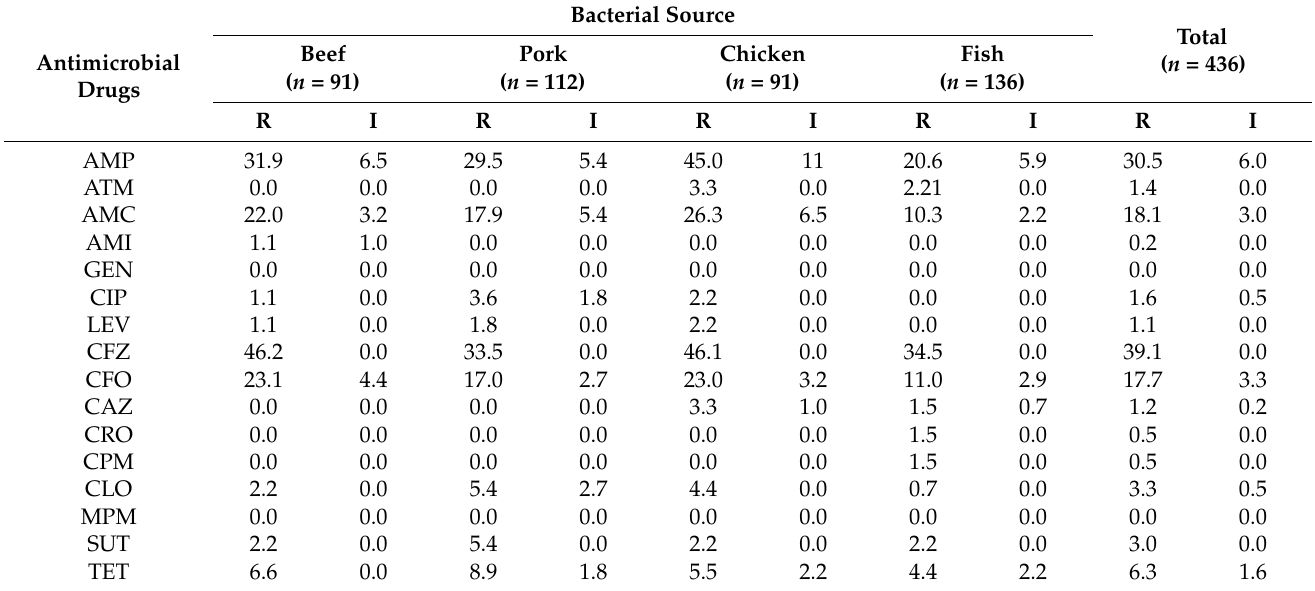
Table 2. Antimicrobial susceptibility patterns (%) of mesophilic facultatively anaerobic Gram-negative rods presumptively characterized as enterobacteria isolated from meat and fish